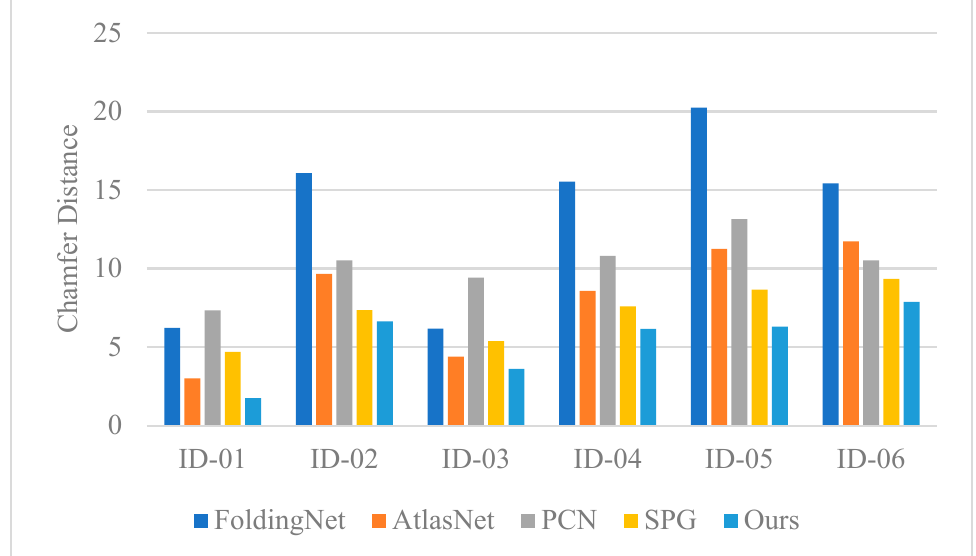
Figure 7. CD distance after point cloud completion of different models.